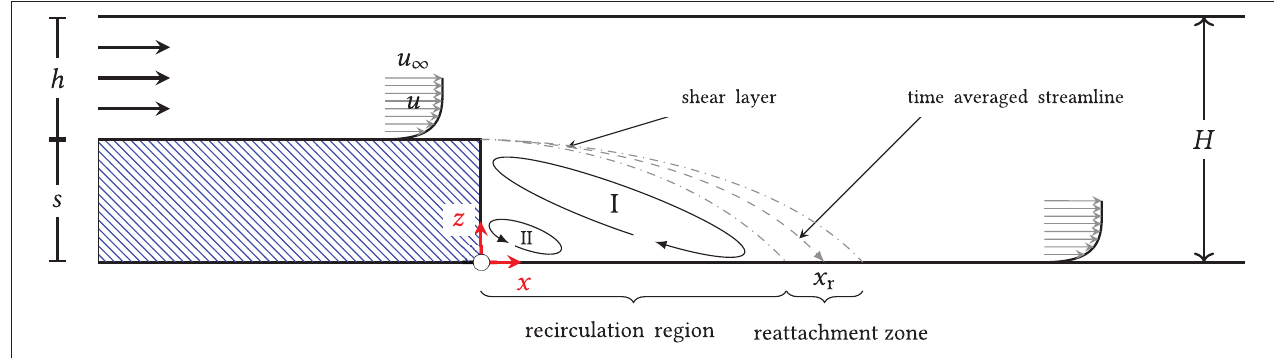
FIGURE 1 | Principle of the backward-facing step flow; two-dimensional, schematic representation: when flow through a channel of height h is instantly expanded to height H , a shear layer develops downstream of the step. Due to the Kelvin-Helmholtz instability, vortices in that shear layer might form, build up, and induce turbulence, which then hits the region in the reattachment zone in the step wake. Upstream that zone a recirculation region develops, which includes a primary (I) and a secondary vortex